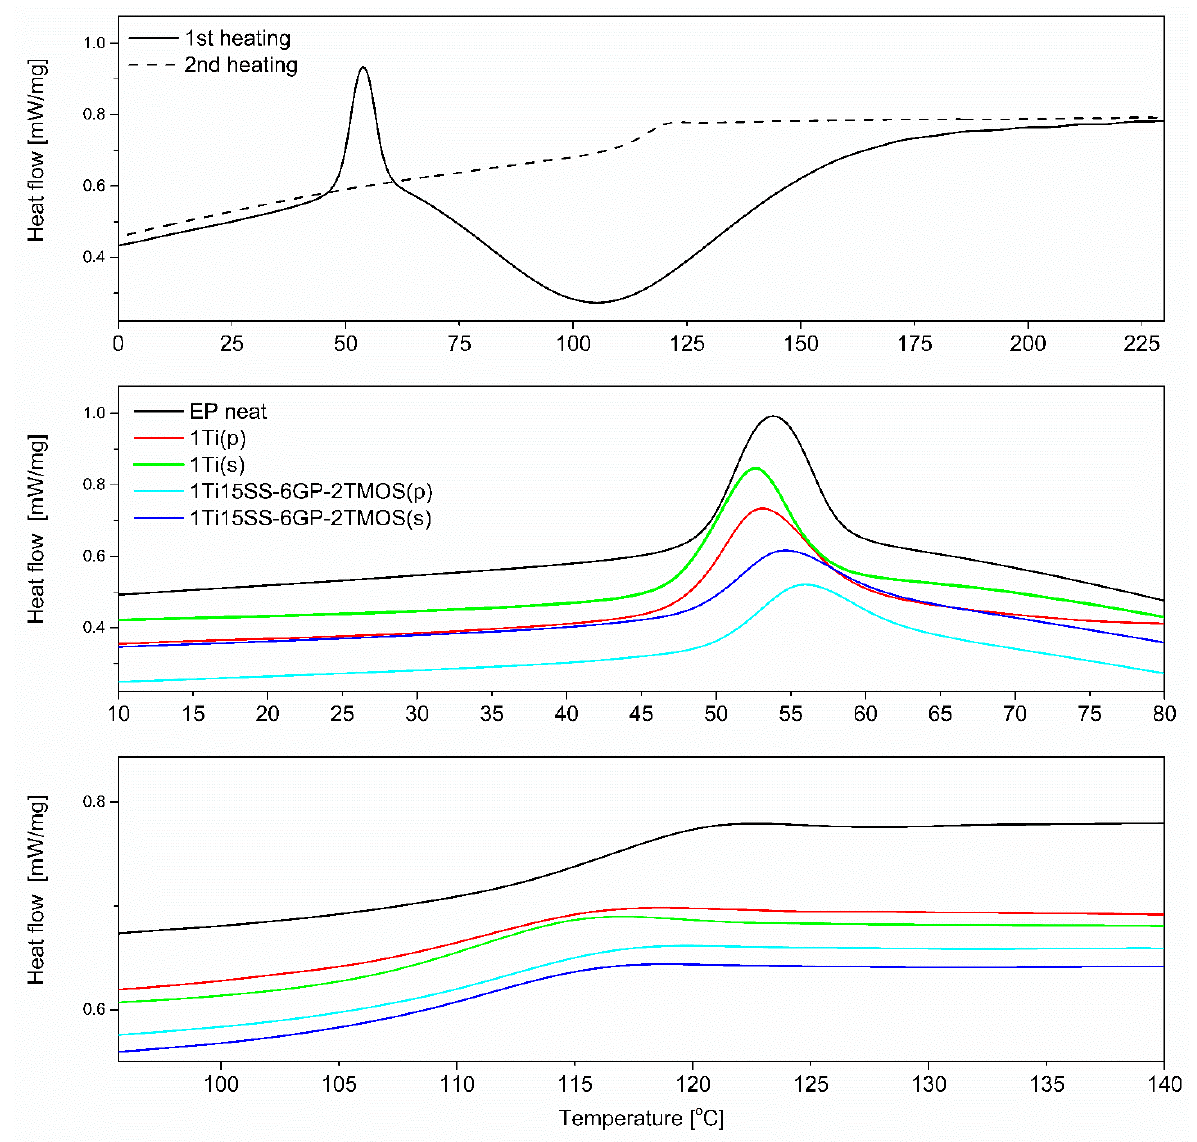
Figure 17. DSC plots of selected epoxy systems; neat EP (top); T gu region (middle), T g region (bottom).